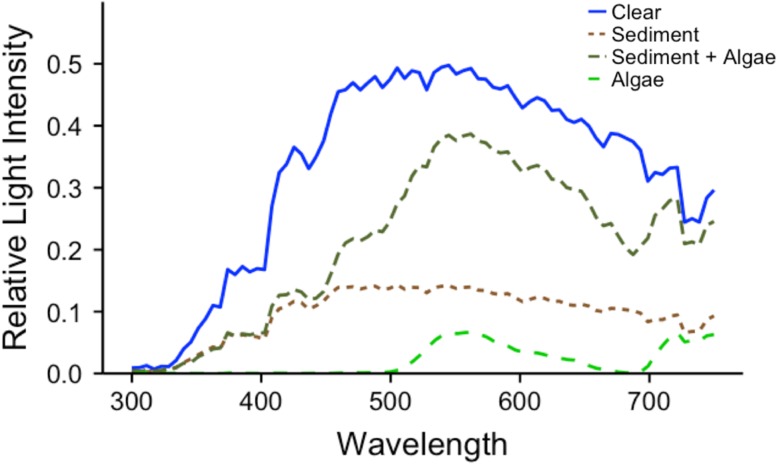
Relative (to ambient) light intensity spectra measured as down-welling irradiance 15 cm below the surface of the water in the optomotor tank in clear water (blue line), at 20 NTU of sedimentary turbidity (brown line), algal turbidity (green line) and a combination of algal and sedimentary turbidity (olive line). Natural daylight provided ambient light. Data was plotted using loess smoothing (span = 0.02).